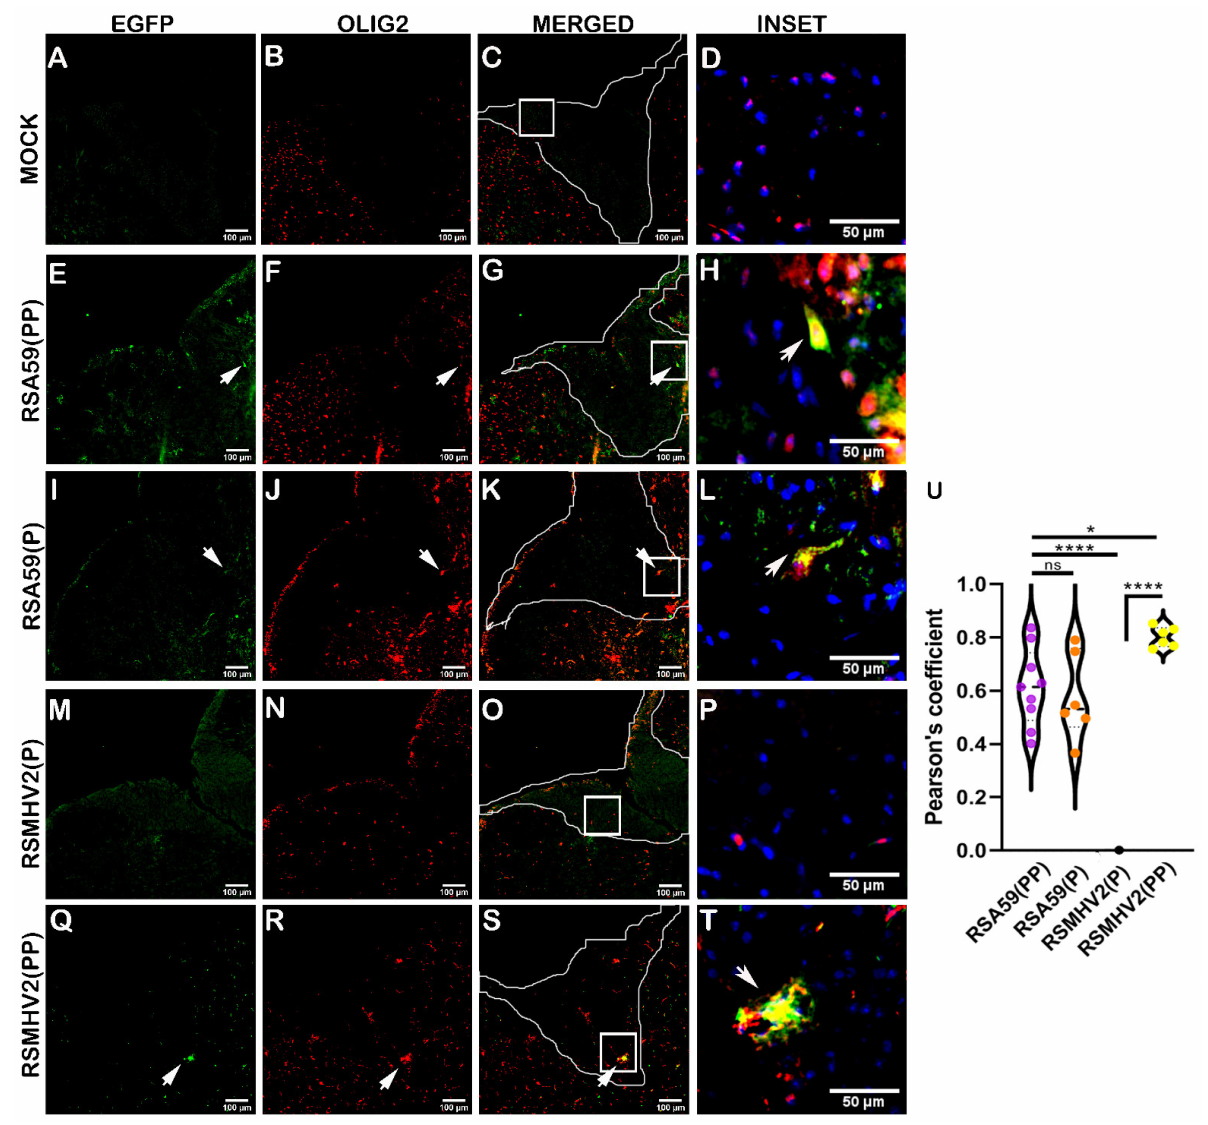
Figure 9. Colocalization of two proline containing strains RSA59(PP), RSMHV2(PP), and single proline containing strains RSA59(P), and RSMHV2(P) infection within mature oligodendrocytes in mouse spinal cords at day 5 p.i. Cryosections of infected mouse spinal cords alongside mock-infected mice were immunofluorescently labeled with Olig2 ( B , F , J , N , R ). EGFP denotes viral antigens in infected mice ( E , I , M , Q ) and mock-infected mice ( A ). Images of EGFP and Olig2 were merged with an outline of dorsal white matter highlighted in Panel ( C , G , K , O , S ). Arrowheads indicate virus infected oligodendrocytes. Higher magnification of colocalization of EGFP and Olig2-positive cells in the white matter is indicated as insets highlighted by a white rectangle area and are presented in panel ( D , H , L , P , T ). RSA59(PP) infected sections are shown in Panel ( E – H ), RSA59(P) infected sections are shown in Panel ( I – L ), RSMHV2(P) infected sections are shown in Panel ( M – P ), and RSMHV2(PP) infected sections are shown in Panel ( Q – T ). The percentage of infected oligodendrocytes in white matter was manually calculated and plotted in a violin diagram ( U ). The One-way ANOVA was used to compare RSA59(PP) with RSA59(P), RSMHV2(P), RSMHV2(PP) and RSMHV2(P) with RSMHV2(PP). The level of significance was taken at p < 0.05. * p < 0.05, **** p < 0.00001, and ns denotes